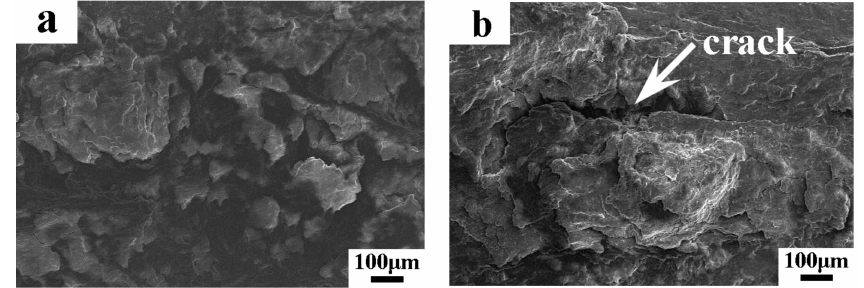
Figure 9. ( a , b ) SEM morphologies of wear scars in NaCl solution at F n = 30 N and D = ± 150 µ